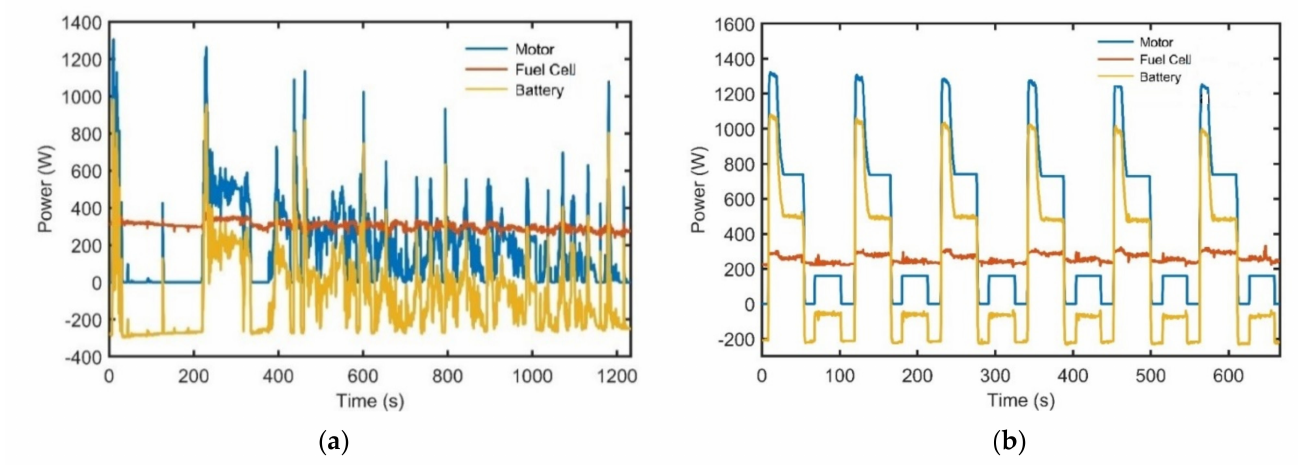
Figure 5. Power distribution of the passive hybrid power system for the e-scooter: ( a ) Power requirement under the Shanghainese urban driving cycle; ( b ) Power requirement under the Chinese standard driving